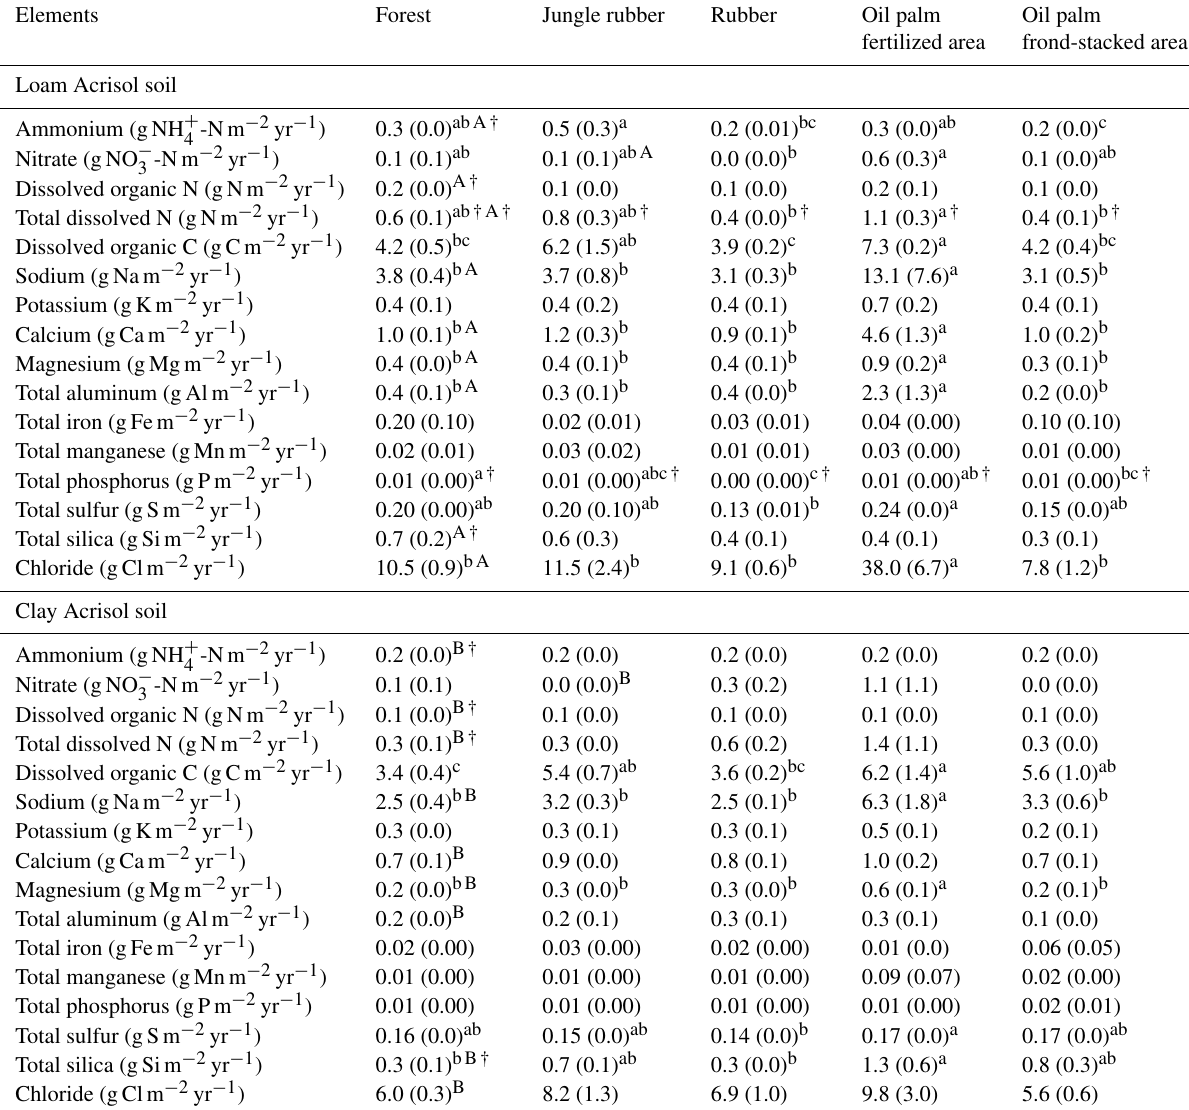
Table 4. Mean ( ± SE, n = 4, except for oil palm n = 3) annual (2013) nutrient leaching fluxes measured at a depth of 1.5m in different land uses within the loam and clay Acrisol soils in Jambi, Sumatra, Indonesia. Means followed by different lowercase letters indicate significant differences among land uses within each soil type and different uppercase letters indicate significant differences between soil types for each reference land use (linear mixed-effects models with Fisher’s LSD test at P ≤ 0 . 05 and † at P ≤ 0 . 09 for marginal